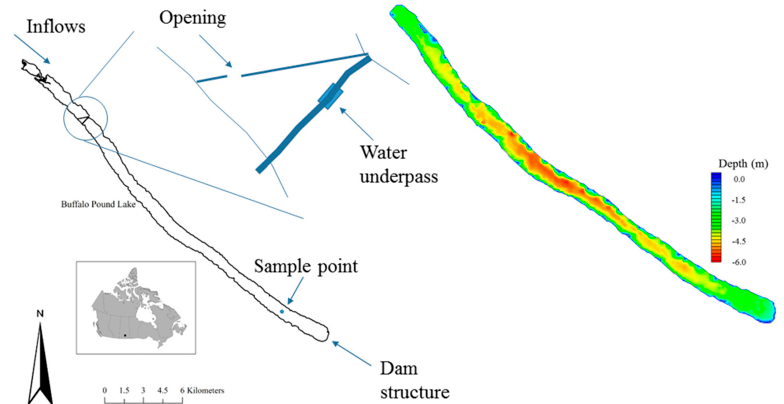
Figure 1. Buffalo Pound Lake, Saskatchewan, Canada. Mean depth is 3.8 m with a maximum depth of 5.98 m. Mean residence time is highly variable (6 to 30 months). Flow is in a southeast direction. The black reservoir outline is to the provided scale. The digital elevation model (DEM) shows bathymetry for the main body of the lake downstream of the underpass.